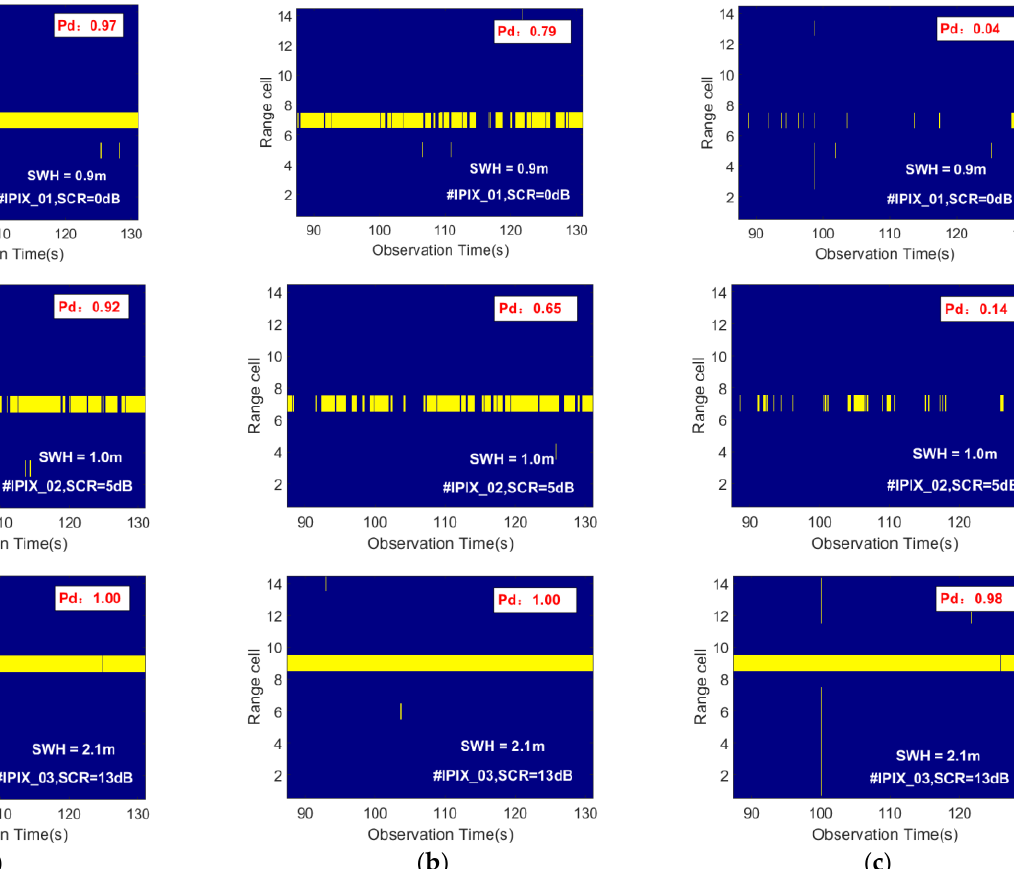
Figure 9. Comparison of different detection methods in different sea states. The de- tection results are obtained from the test samples and the radar observation time is 0.512